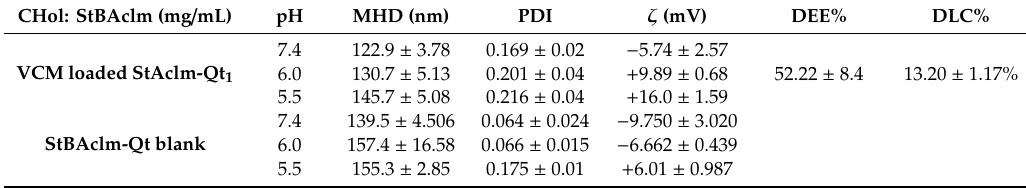
Figure 1. ( A ) Morphology of VCM-StBAclm-Qt 1 quatsomes scale bar: 200 nm and ( B ) size distribution of VCM-StBAclm-Qt 1 quatsomes measured using dynamic light scattering (DLS). Table 1. MHD, PDI, ζ , DEE%, and DLC% of initial screening VCM-StAclm-Qt quatsomes. CHol: StBAclm (mg /